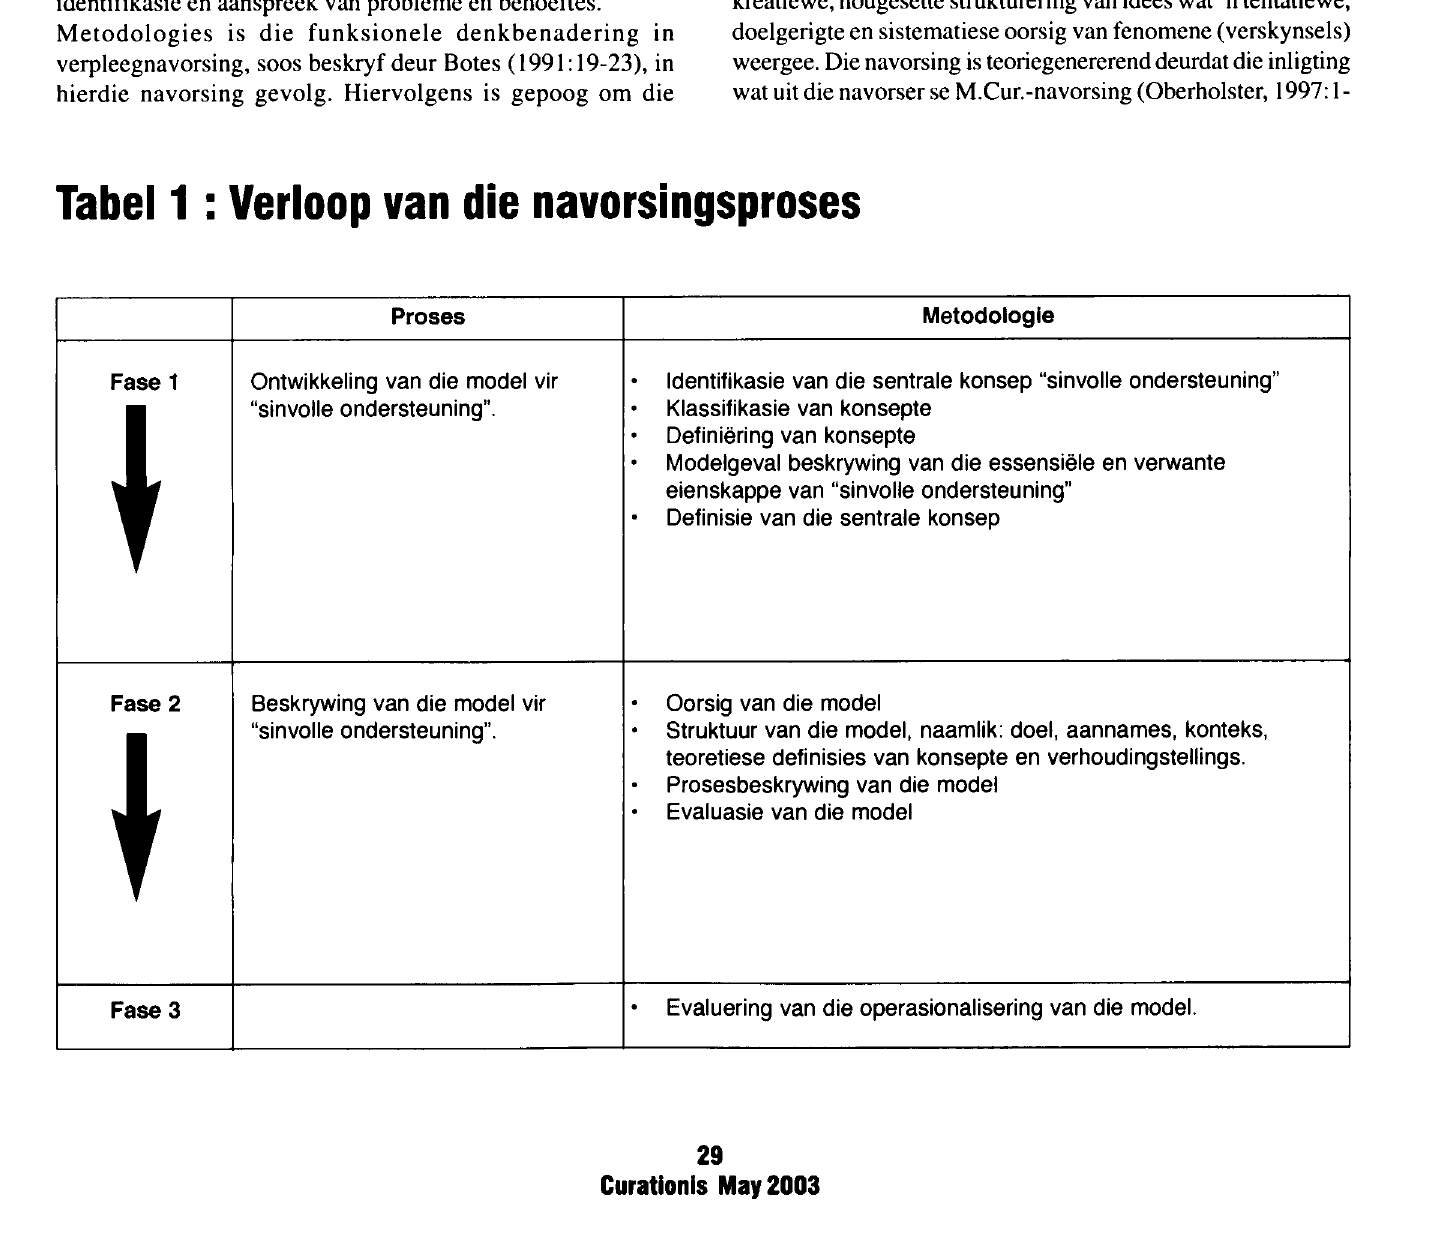
Tabel 1 : Verloop van die navorsingsproses